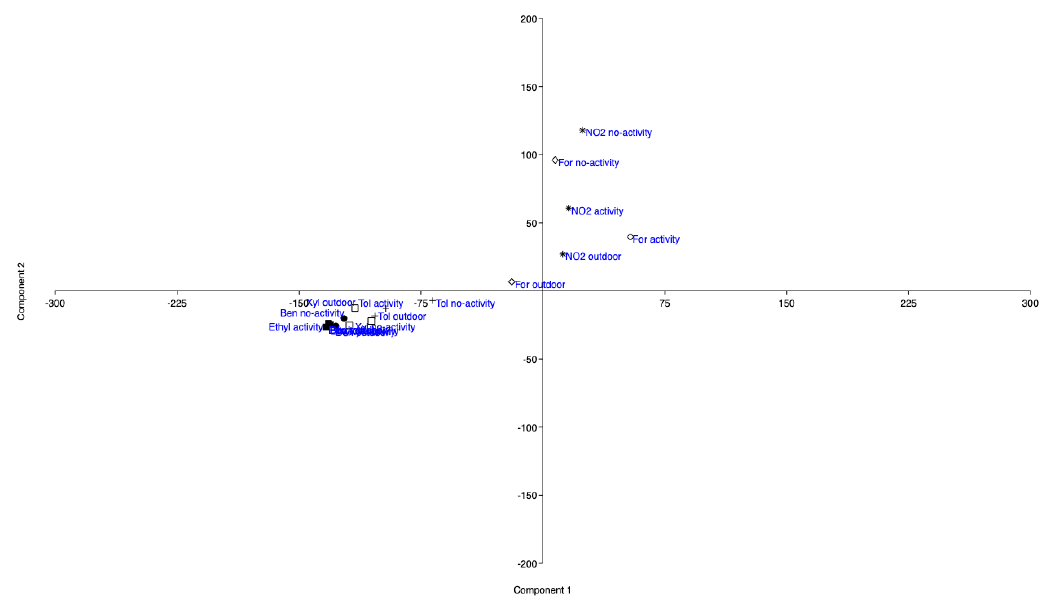
Figure 6. Principal component analysis (PCA) applied to the overall data. Component 1: compounds from photochemical activity; Component 2: compounds from combustion processes.